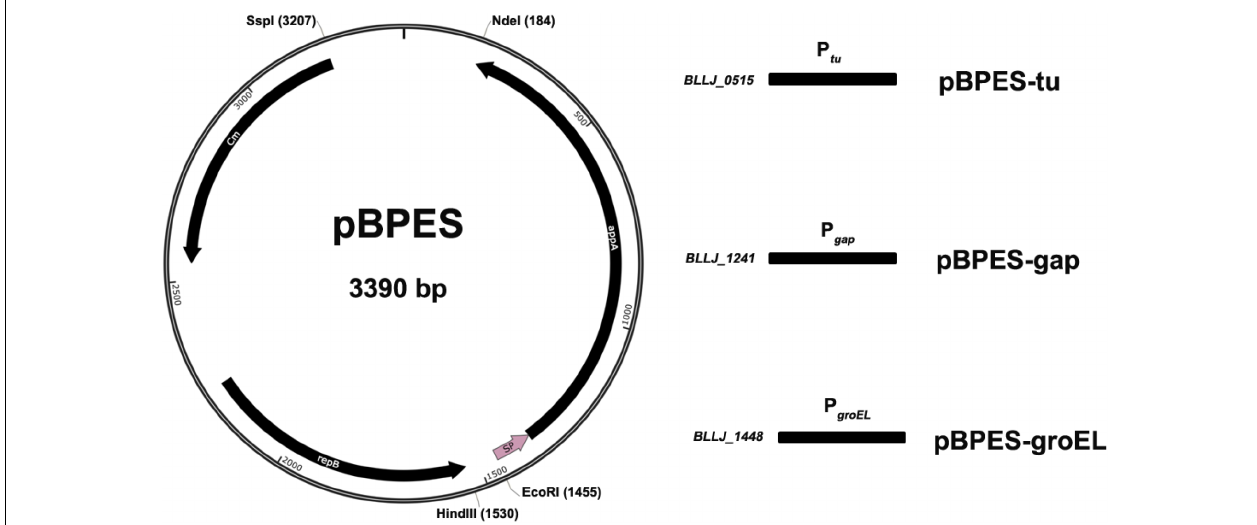
FIGURE 1 | Schematic presentation of plasmid pBPES and its derivatives. Plasmid pBPES was the backbone used for screening promoters. The vector was an Escherichia coli – Bifidobacterium longum shuttle plasmid based on pUC57 using pMB1 cloned from pTB60 as a replicon, Cm r as a selection marker, SP as a signal peptide. Chloramphenicol was used for selection of the plasmid at a concentration of 25 µ g/mL in both E. coli and B. longum. P tu , P gap , and P groEL were predicted promoters of gene BLLJ_0515 , BLLJ_1241 , and BLLJ_1448, respectively. They were cloned into pBPES between restriction sites of Hind III and EcoR I. The resulted three derivative plasmids were named as pBPES-tu, pBPES-gap, and pBPES-groEL,